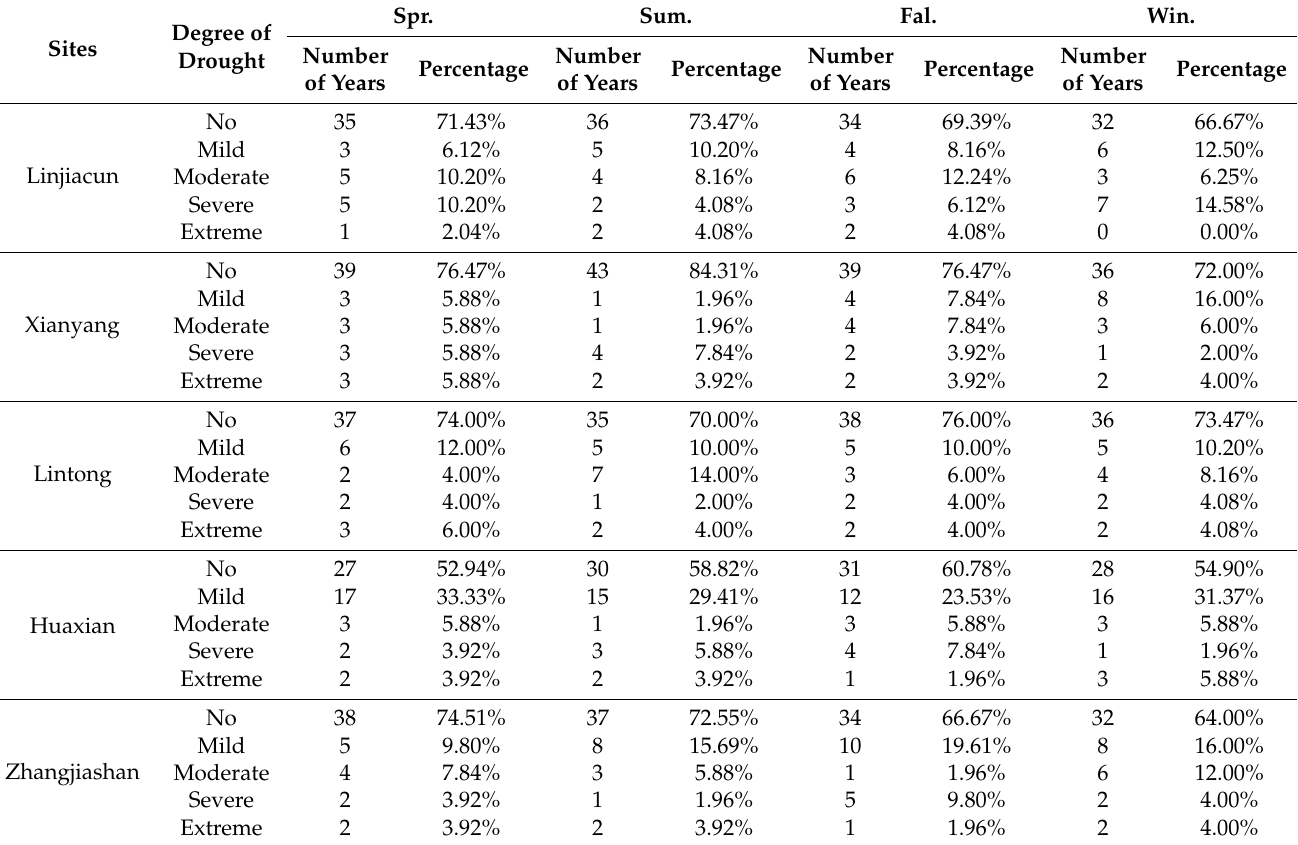
Table 8. Drought levels occurring in all seasons at the Weihe Huaxian